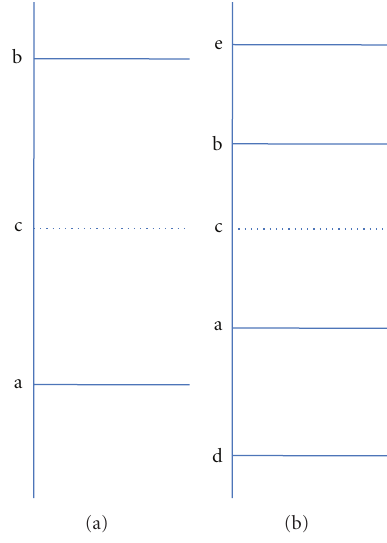
Figure 8: Wavelet coe ffi cient and threshold